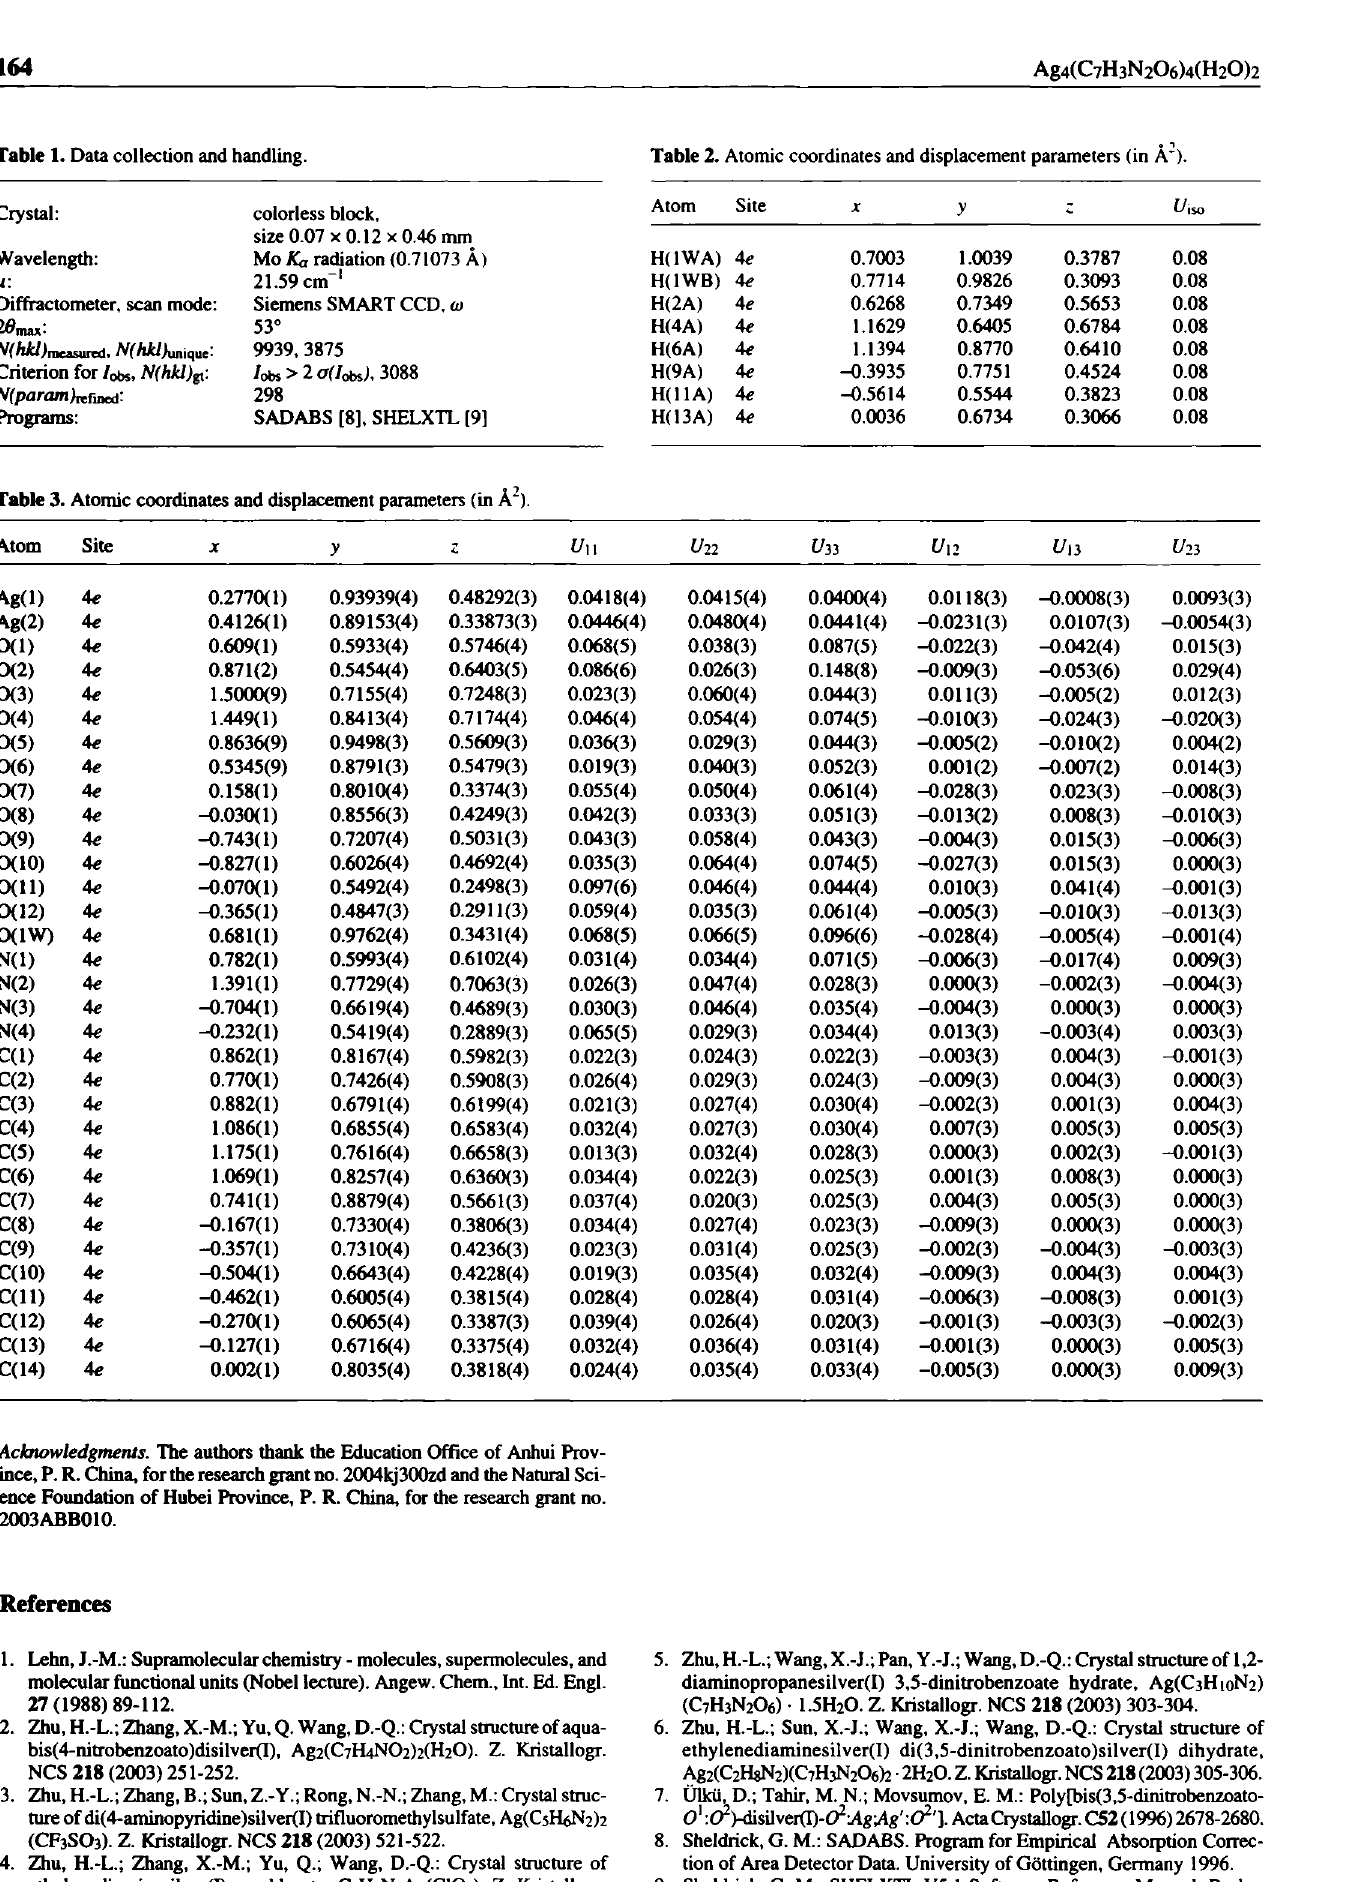
Table 1. Data collection and handling. Table 2. Atomic coordinates and displacement parameters (in A : ).